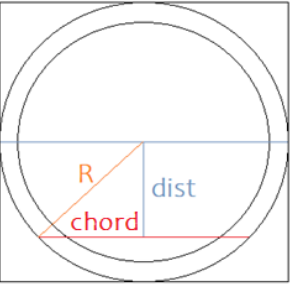
Figure 12. Qualitative scheme for chord individuation.